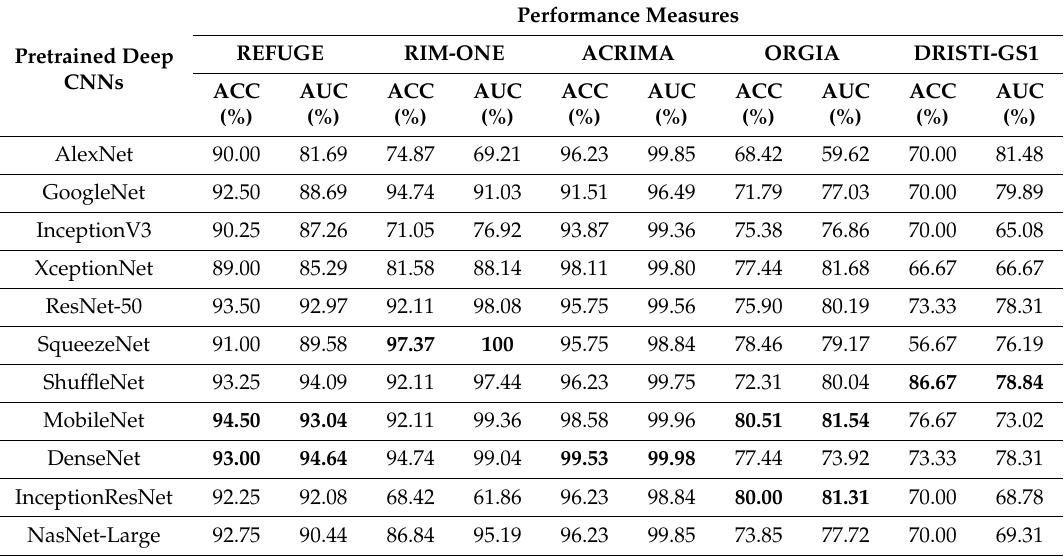
Table 5. P1: Transfer learning using eleven pretrained networks for glaucoma classification.